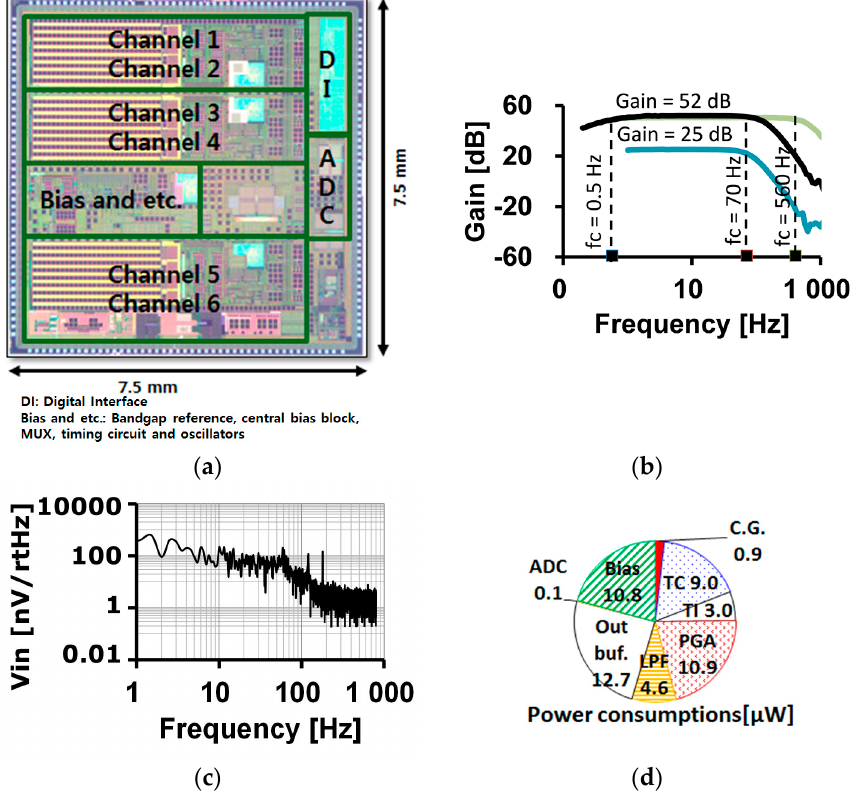
Figure 9. Fabricated AFE and basic characteristics; ( a ) chip photograph; ( b ) readout channel frequency response at PGA gain = 2; ( c ) input referred voltage noise characteristics of the readout channel; ( d ) power consumption breakdown of the analog readout channel.